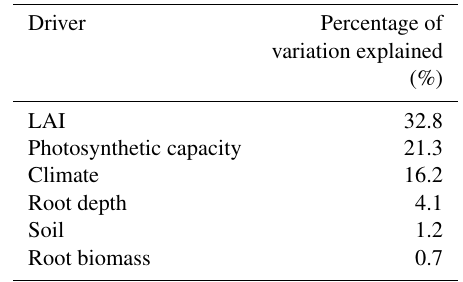
Table 6. The proportion of variation in GPP across seven GEM Amazonian permanent sample plots explained by photosynthetic drivers in SPA. Model drivers were alternated individually at each plot with that of all other plots and the resultant change in GPP retrieved. Proportion of variance explained was calculated as the conditional sum of squares divided by the total sum of squares ( n = 476; where the conditions were LAI, photosynthetic capacity, rooting depth, root biomass, climate and